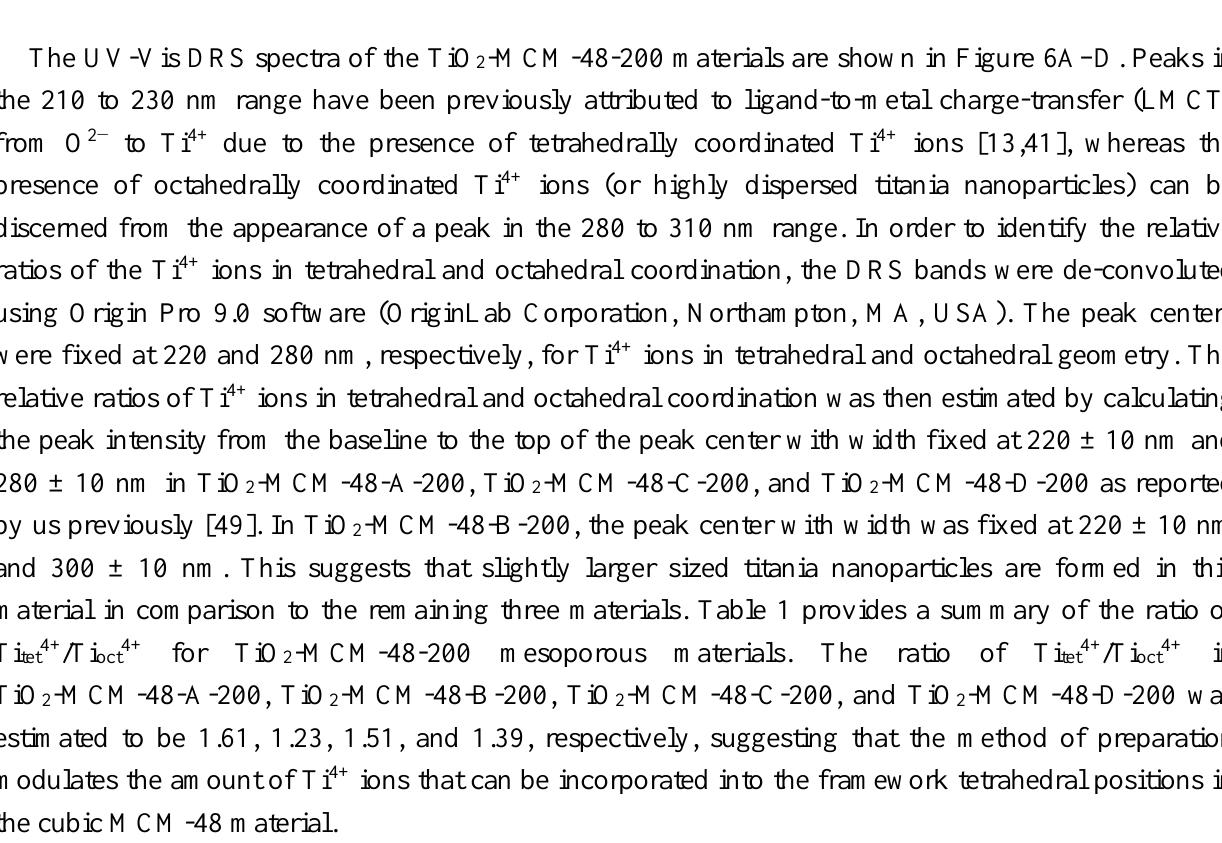
Figure 5. ESR spectra of TiO 2 -MCM-48-200 materials prepared by four different